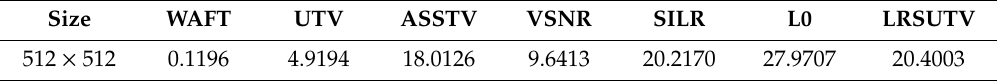
Table 6. Running time of various methods. Units are